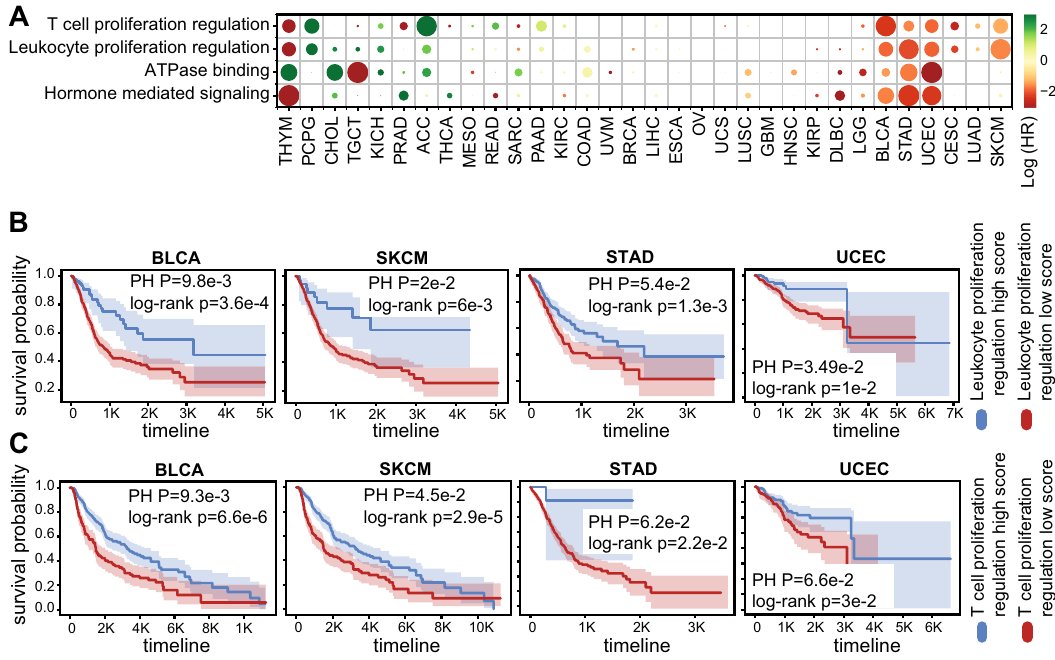
Fig. 4 | Biological process-based random forest classi fi ers predict overall sur- vival in TCGA. A Heatmap showing the hazard ratios (log-transformed) obtained through overall survival prediction using the classi fi cation scores of the selected process-basedrandomforestclassi fi ers. B Kaplan – Meiersurvivalcurvescomparing betweenTCGA samples from four cancer types, with high vslow-prediction scores of the RF model, when trained using mutations within the leukocyte-proliferation regulation process. The Cox proportional hazards and log-rank P values are